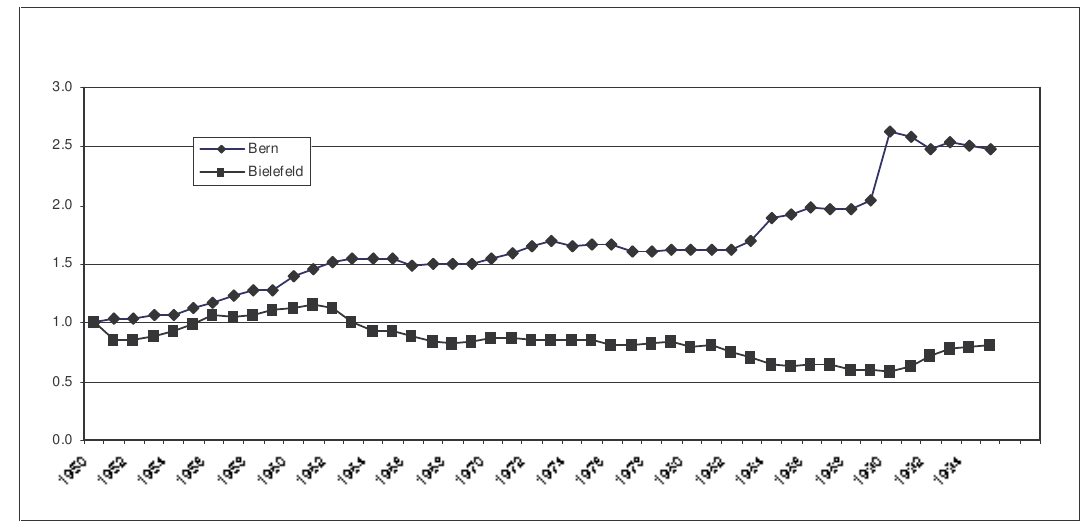
Figure 6. Public transport: comparison Berne - Bielefeld: trips 1950-1995. 1950=100 Sources: Jahresberichte der Verkehrsbetriebe Bern, div. vol., the big increase between 1990 and 1991 is a result of a changed method of calculating passengers and therefore an